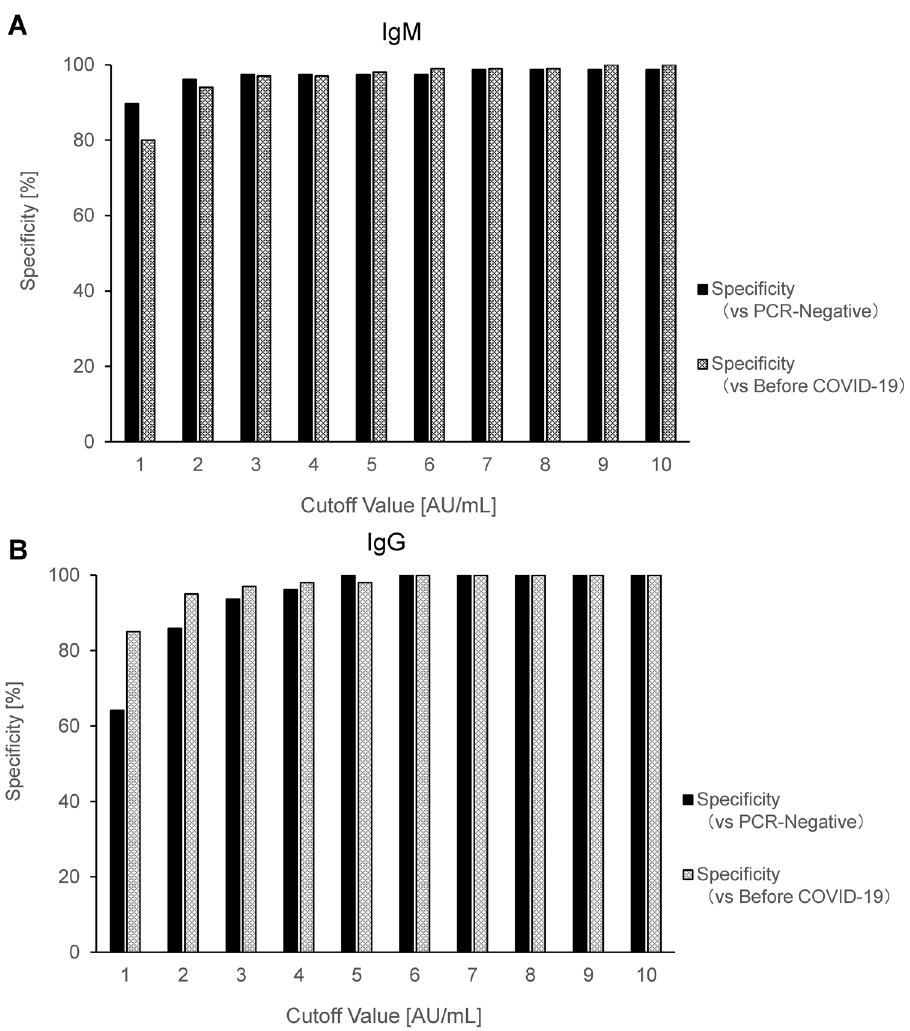
Figure 4. Comparison of the specificity against “RT-PCR-negative group” with that against “Before COVID- 19 group”. We compared the specificity against “RT-PCR-negative group” (n = 79) with that against “Before COVID-19 group” (n = 100), which contains healthy subjects in 2017. ( A ) SARS-CoV-2 IgM, ( B ) SARS-CoV-2